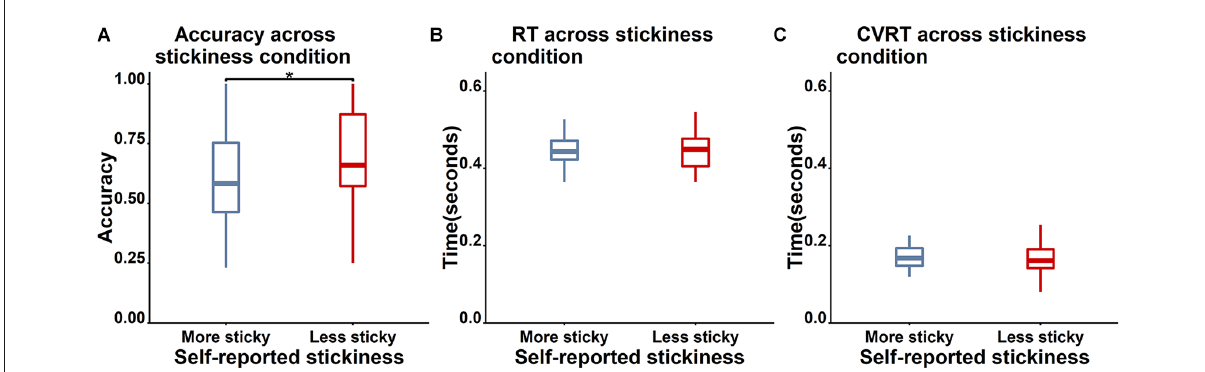
FIGURE3 Boxplot of behavioral performance differences between less sticky trials (red) and more sticky trials (blue). (A) Accuracy for Nogo trials is significantly higher for less sticky trials (“*” indicates a p value which is lower than 0.05). (B) and (C) No significant differences between more and less sticky trials were observed in RT and cvRT of Go trials.